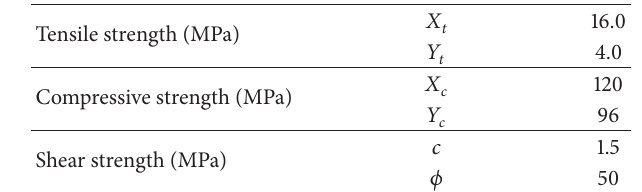
Table 5: Mechanical properties of rock mass in the direction of joint